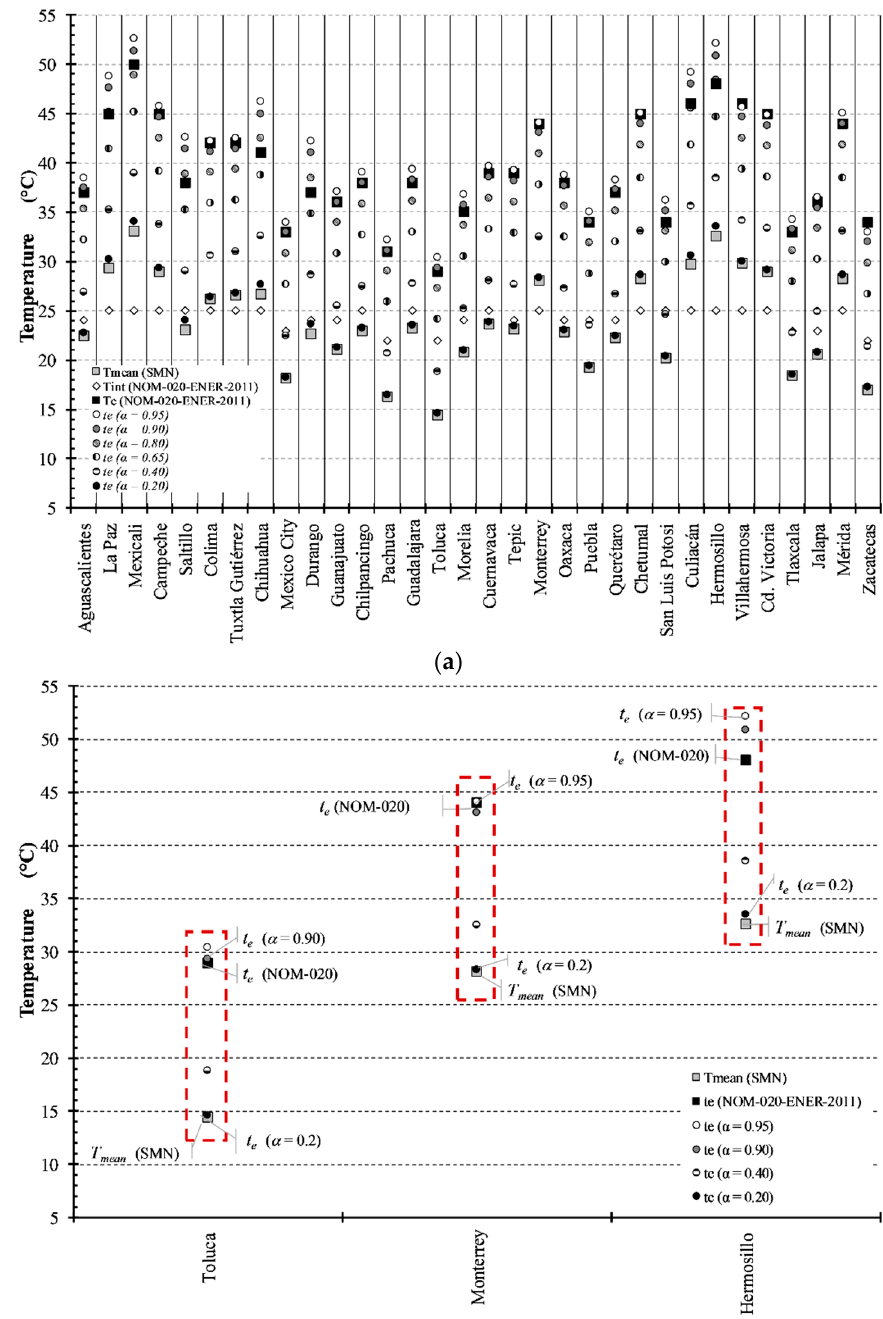
Figure 6. Equivalent temperature ( t e ) at different solar absorptivity values. ( a ) All cities, several absorptivity values; ( b ) Selected cities, simplified view.